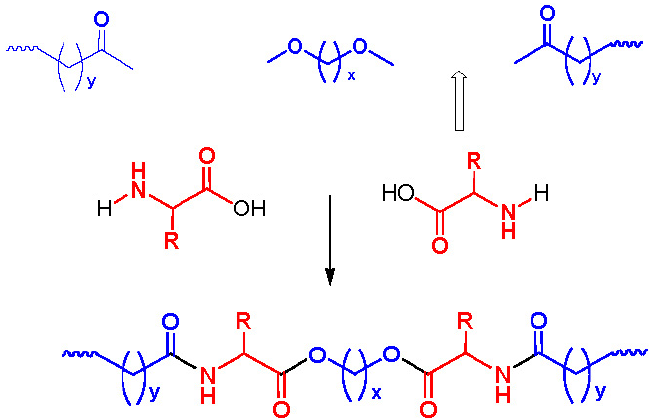
Figure 17. Schematic representation of AABBP as products of the insertion (empty arrows) of AA between ester